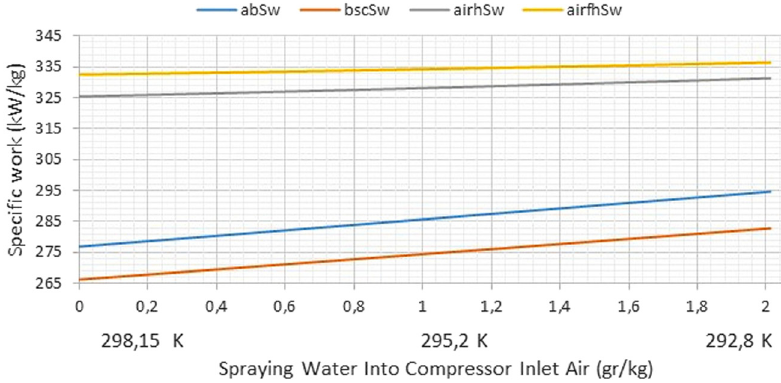
Figure 11: Variation of the speci fi c work with spraying water into compressor inlet air ( g/kg ) for ab, bsc, airh, and airfh cogeneration systems [ 10 ] .